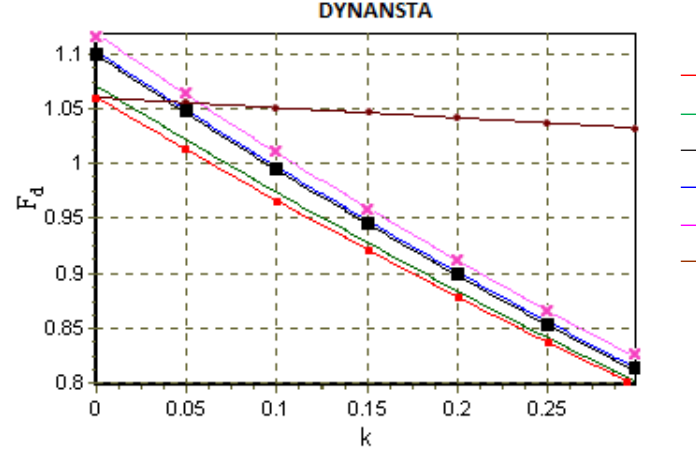
Figure 7: Effect of the core